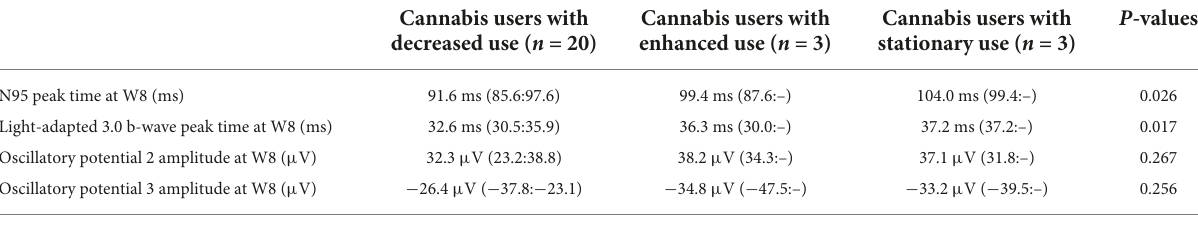
TABLE 4 Electroretinogram (ERG) parameters of participants. Variation of cannabis use between week 0 (W0) and week 8 (W8)